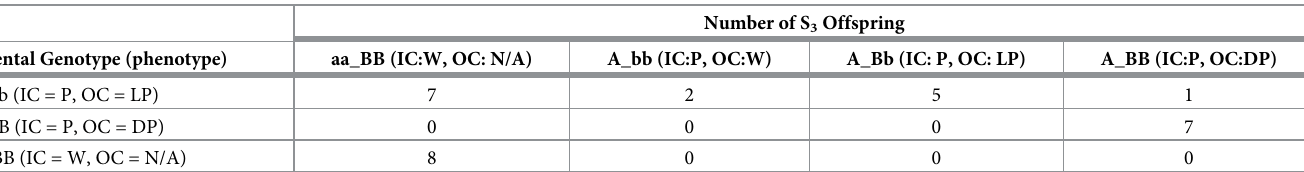
Table 2. Phenotypes of S 3